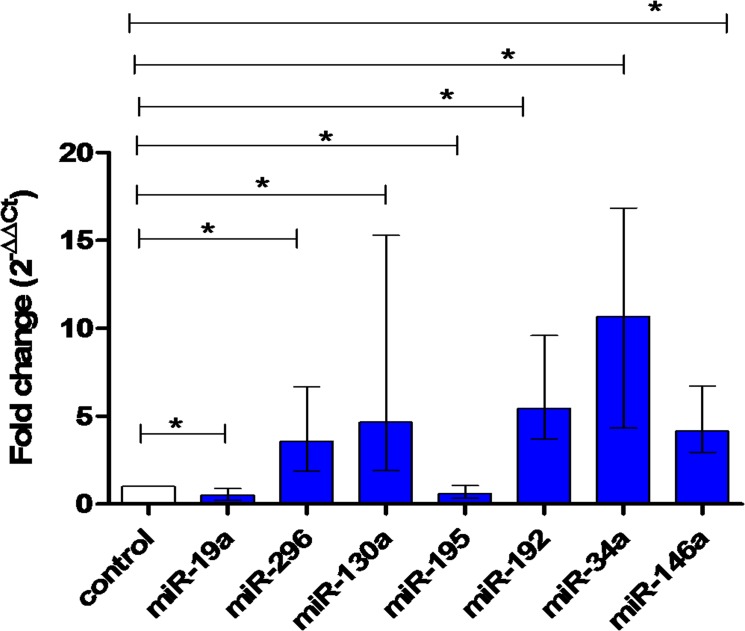
Differential expression of serum miRNA levels in HCC and healthy controls.Relative expression of miRNAs miR-19a (P = 0.0002), miR-296 (P<0.0001), miR-130a (P<0.0001), miR-195 (P = 0.04), miR-192 (P<0.0001), miR-34a (P<0.0001), and miR-146a (P<0.0001) in serum of HCC (n = 112) compared to healthy controls (n = 42). Data are presented as median with interquartile range. Data were analyzed by Mann-Whitney U-test.* means statistical significance (P<0.05).